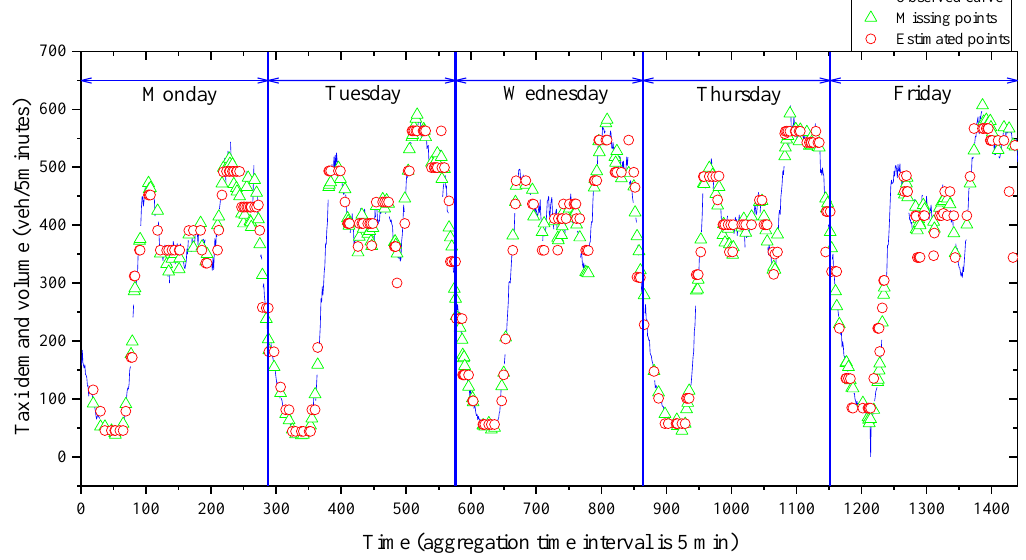
Figure 5. Comparisons between the missing values and the estimated values.